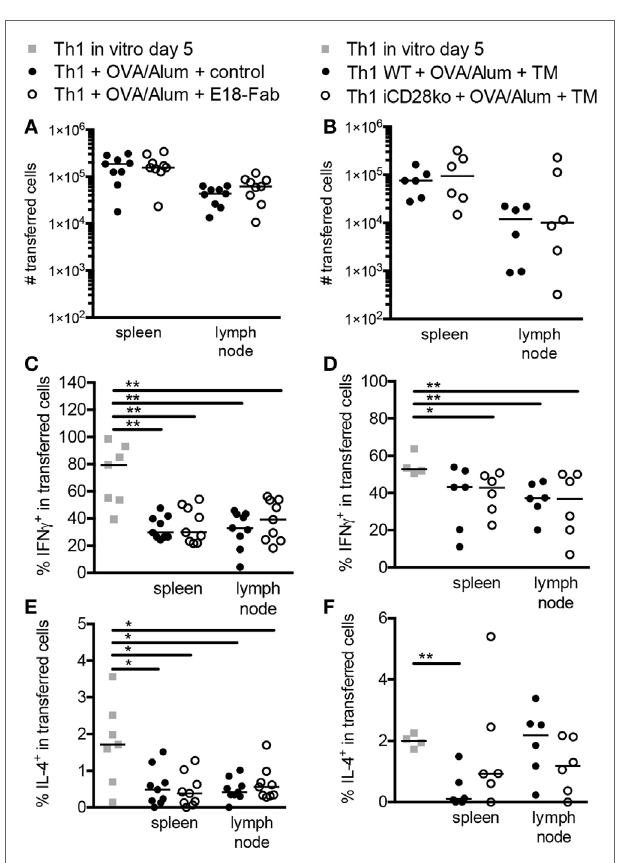
FigUre 2 | CD28 costimulation does not modulate differentiation of mouse T helper 1 cells in vivo . Additional analysis of the experiments presented in Figure 1 . (a) Absolute cell numbers and medians of transferred cells 7 days after antigen administration with E18-Fab-mediated CD28 blockade or (B) inducible CD28 deletion. (c,D) Frequencies of interferon γ and (e,F) interleukin-4 producing cells among transferred cells 7 days after antigen administration in mice with (c,e) E18-Fab-mediated CD28 blockade or (D,F) tamoxifen-induced CD28 deletion. The data shown were pooled from three to five independent experiments with a total of 6–9 mice per group and tested with a two-tailed Mann–Whitney test (* p < 0.05, ** p < 0.01, *** p < 0.001). Horizontal bars indicate medians per group.